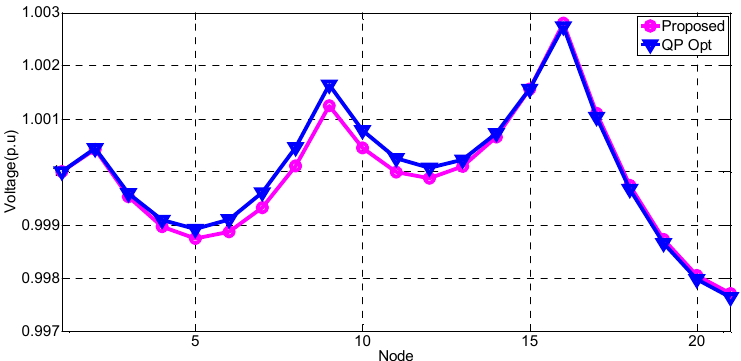
Figure 10. Voltage flattening results for two DGs.